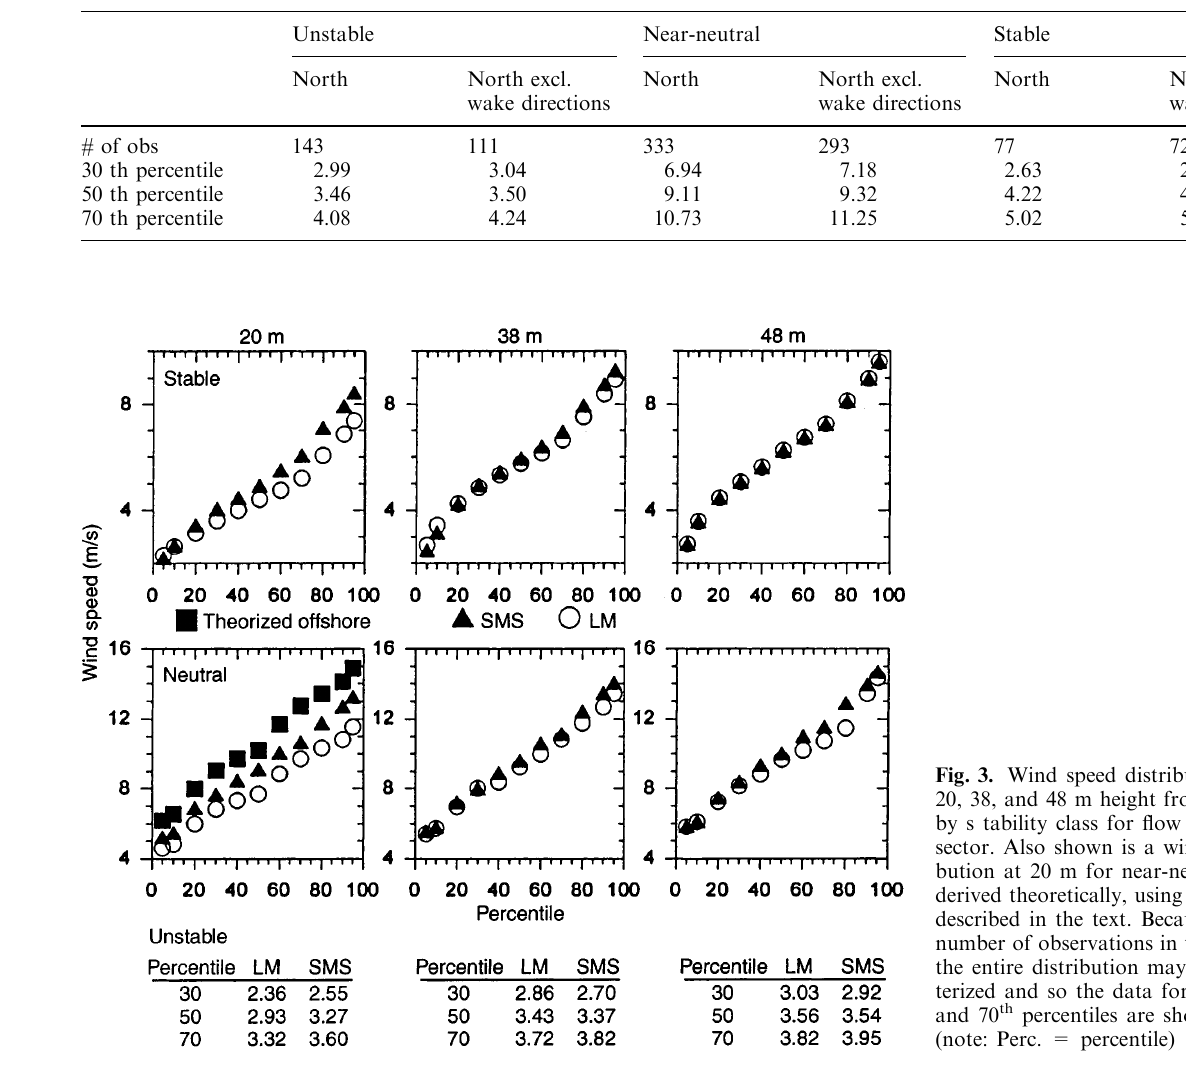
Table 2. Investigation of wake e(cid:128)ects. Variations in wind speed at SMS at 7 m measurement height for the north sector (285 (cid:176) –65 (cid:176) ) using all observations and excluding wind directions subject to wake e(cid:128)ects based on the wind farm orientation (excluded sectors: 20 (cid:176) –